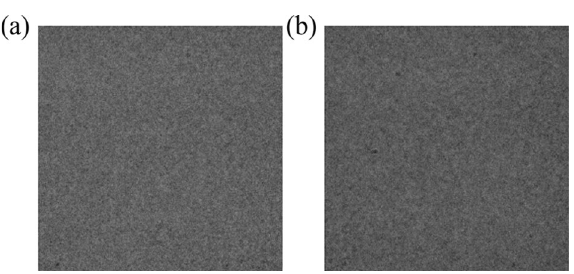
Figure 8. BF2 response image ( a ) System interferogram, ( b ) NO 2 interferogram.